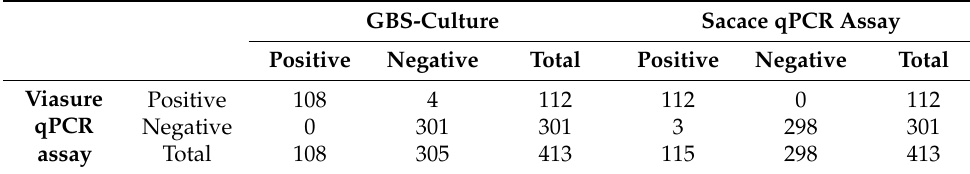
Table 1. Comparison of Viasure qPCR assay results to GBS culture and Sacace qPCR assay